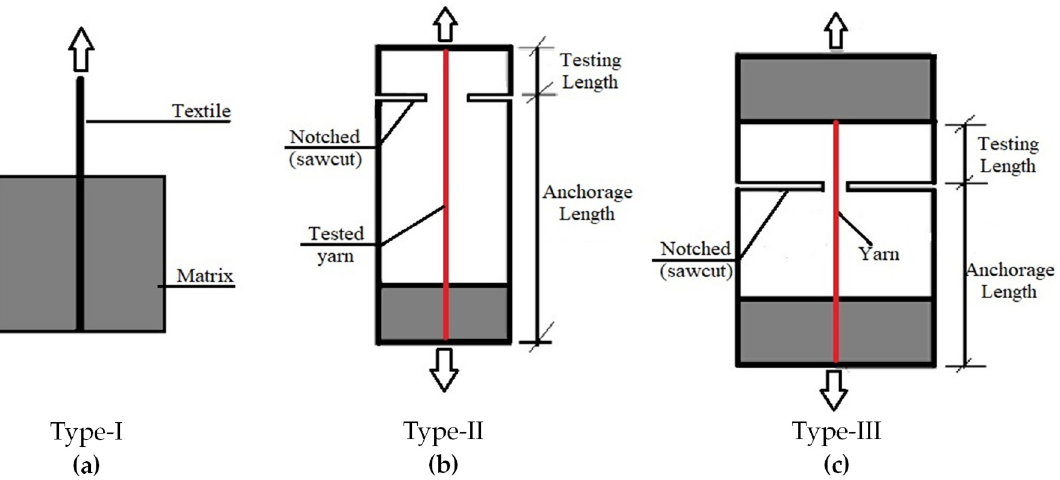
Figure 12. Pullout test setups for bond–slip ( a ) direct pullout ( b ) double-sided unsymmetric and ( c ) double-sided symmetric. ( c ) double-sided